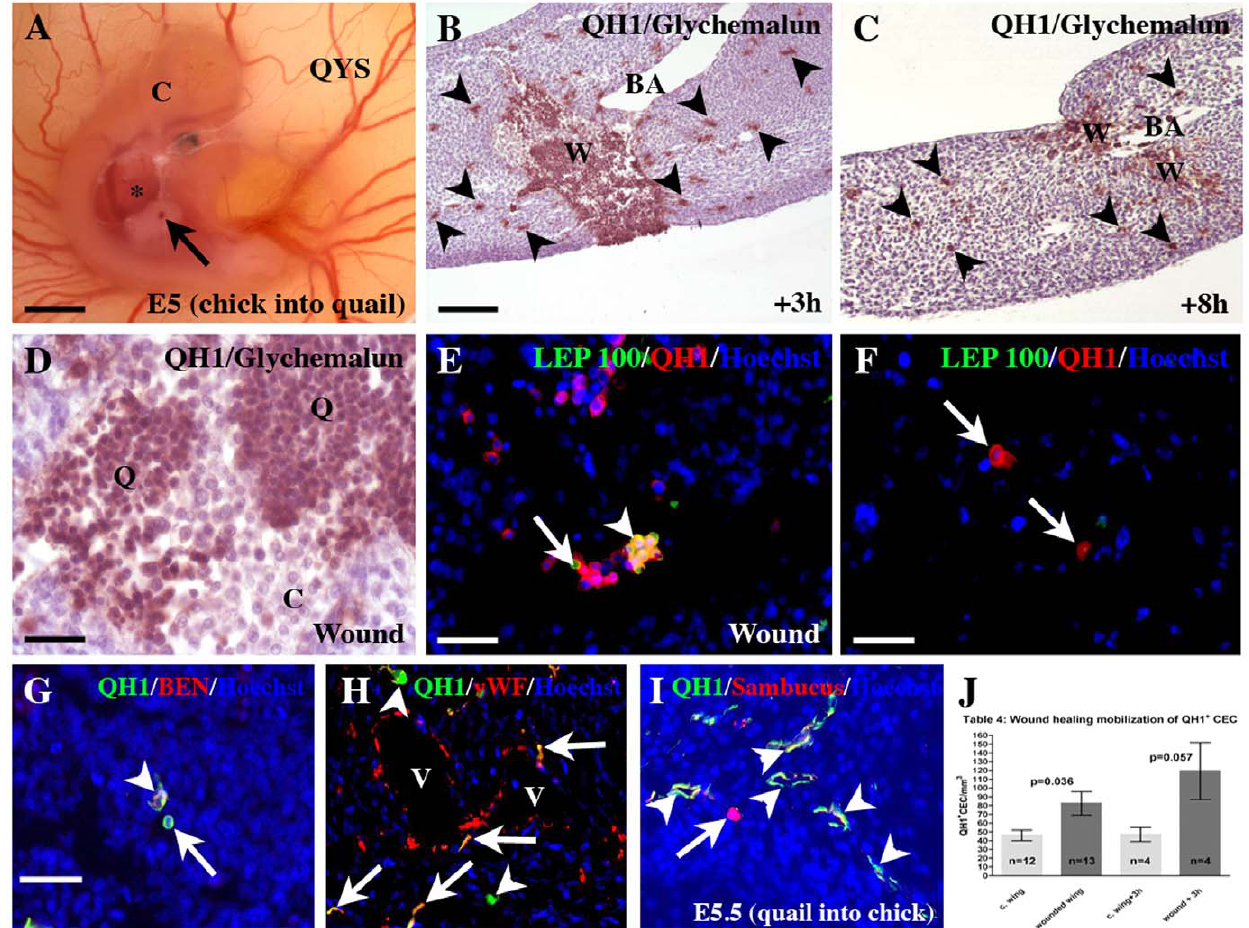
Figure 4. CEC mobilization during wound healing. A) An E5.5 chick embryo (C) developed on a quail yolk sac (QYS). A wound is made in the right wing bud (arrow), which is accessed through a hole in the amnion (*). Bar: 1.2 mm. B, C) Longitudinal sections of wounded wings. Three hours after the operation (B), at the level of the brachial artery (BA), the wound (W) is invaded by an important contingent of chick (blue) and QH1 + quail cells (brown). After 8h (C), the rapid healing of the wound (W) is obvious. Note that numerous QH1 + cells (arrowheads) are present in the wing mesenchyme (B, C). Bar: 85 mm. D) High magnification of the mixed population of brown quail cells (Q) and blue chick cells (C). Bar: 20 mm. E) QH1/ LEP 100 double staining permits to discriminate between QH1 + /LEP 100 + macrophages (arrowhead) and QH1 + /LEP 100 2 cells (arrow) in the wound. Bar: 40 mm. F–H) Identification of QH1 + cells in the mesenchyme of wounded wings. F) QH1 + cells are not macrophages (arrows). Bar: 20 mm. G) A QH1 + /BEN + HC (arrowhead) is identified close to a non hematopoietic QH1 + /BEN 2 cell (arrow). H) In the vicinity of a QH1 2 /vWF + chick vessel (V), Table 4: Mobilization of yolk sac derived CEC during wound healing. A wound on wings induces a statistically significant mobilization of CEC (dark gray) by comparison with CEC concentration in contralateral limbs (clear gray). This mobilization is effective as soon as 3h after wounding (right part of the table).